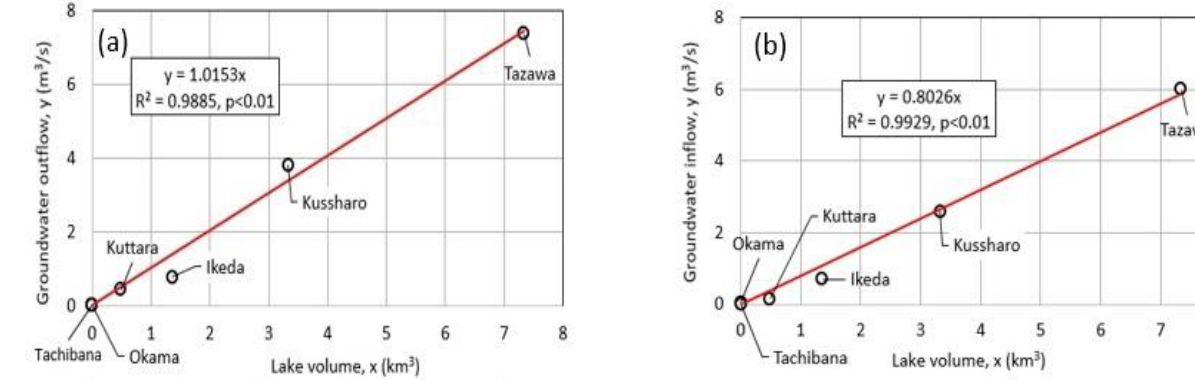
Figure 12. Relations between lake volume and ( a ) groundwater outflow or ( b ) groundwater inflow evaluated for the caldera or crater lakes in Table 4.